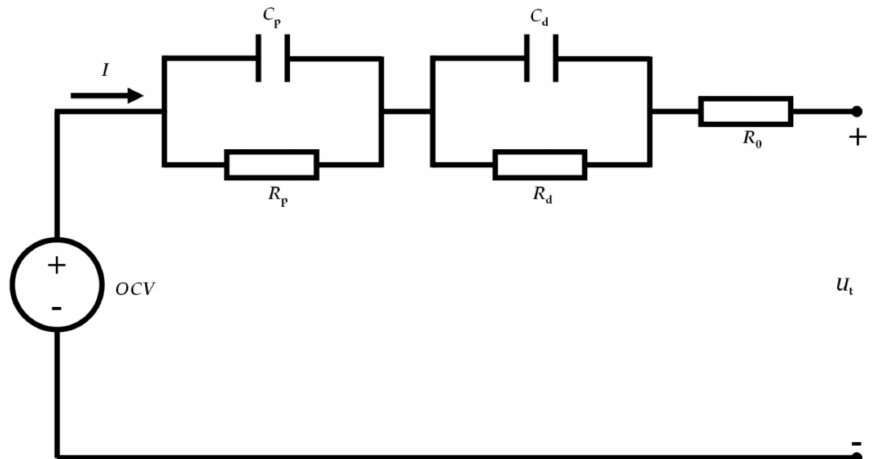
Figure 1. Second-Order RC Equivalent Circuit